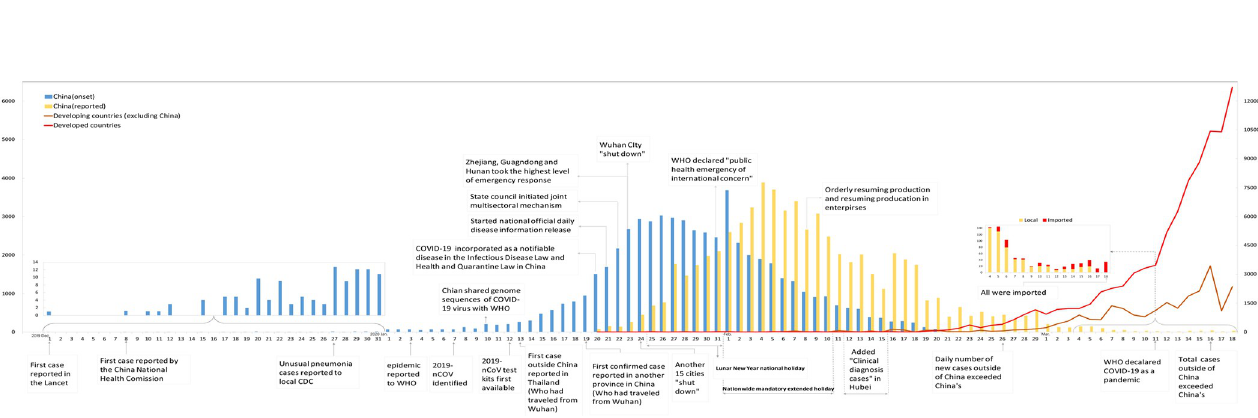
Fig 1. Approximate number of days from infection to onset, to first medical visit, to hospitalization, to laboratory diagnosis, and to discharge with COVID-19 patients.